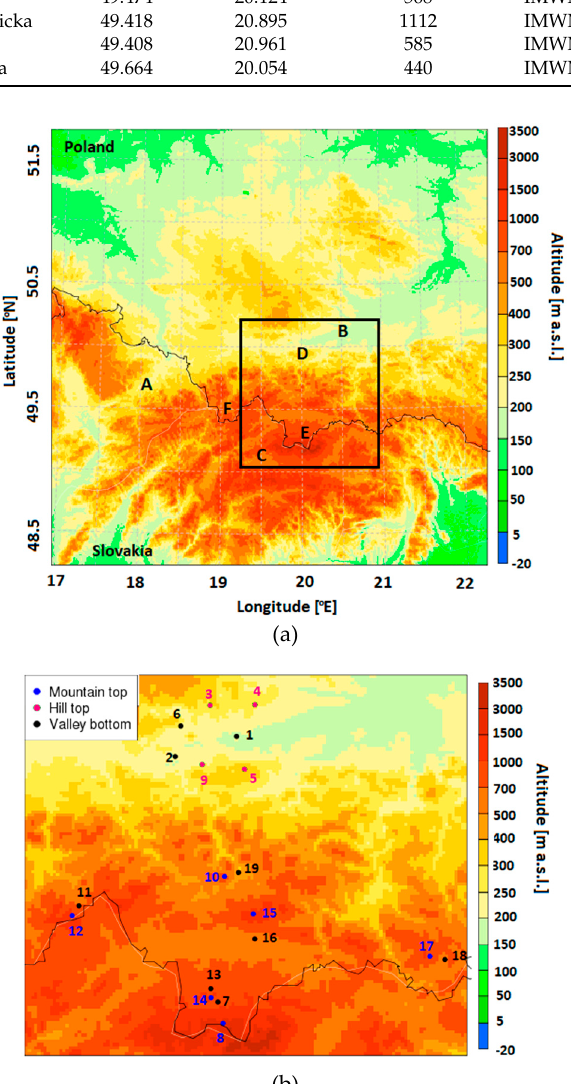
Figure 1. ( a ) Altitude (m a.s.l.) within the domain of ALARO-NH and AROME CMC 1 km models with 1 km × 1 km resolution, and ( b ) locations of meteorological stations/measurement points on the background of orography map for 1 km × 1 km domain of AROME CMC 1 km and ALARO NH models. Analyzed area is marked with a black frame. Explanation of the letters in Fig. 1a can be found in the text of the section 2.1. Numbers in fig. 1b as in Table 1.